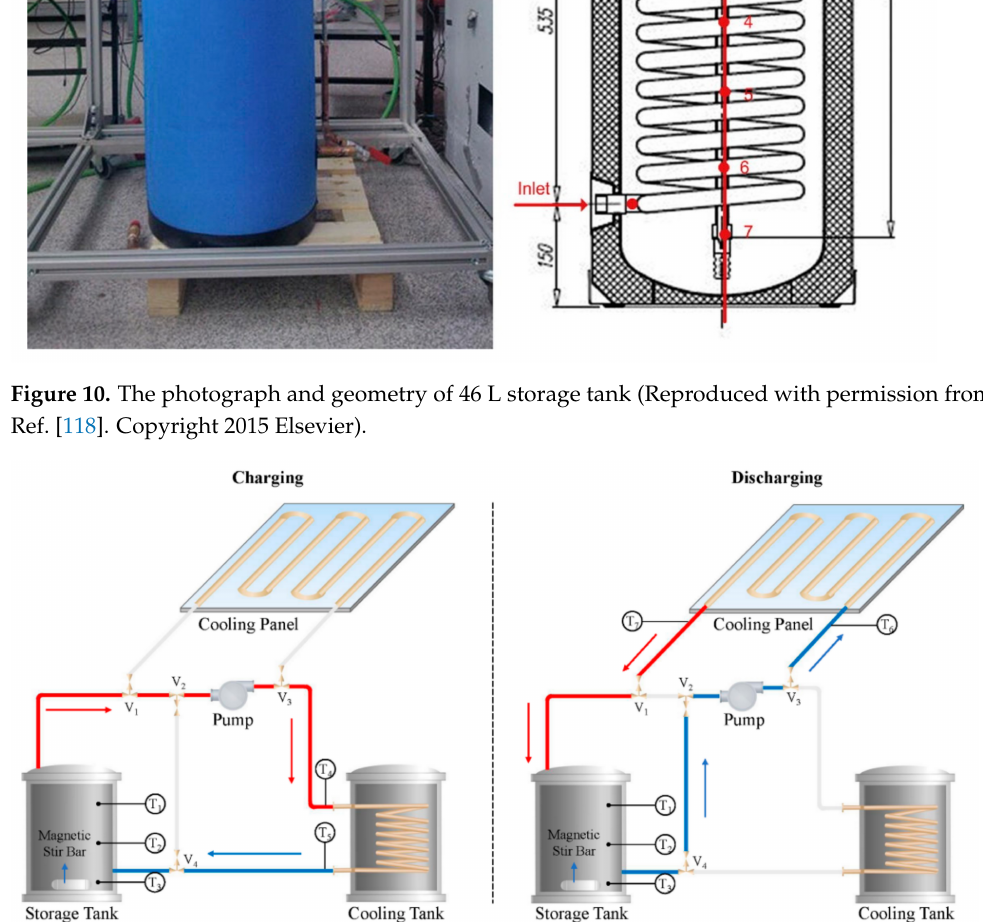
Figure 11. Schematic of charging and discharging mode in a lab-scale TES system (Reproduced with permission from Ref. [120]. Copyright 2021